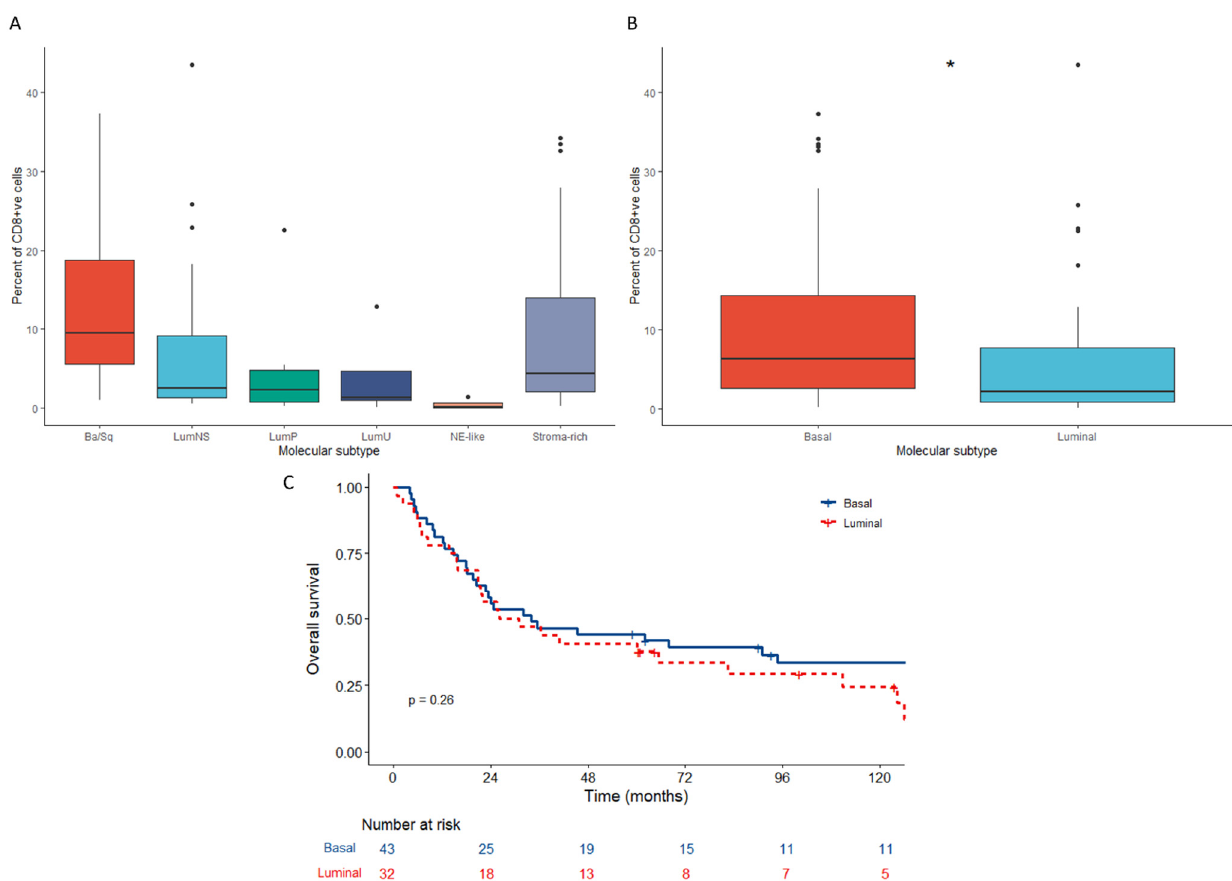
Figure 5. Boxplots showing the association between the percent of CD8 and the molecular subtype as assigned ( A ) using “consensusMIBC” package in R ( n = 80) and ( B ) further stratification into basal (basal/squamous and stroma-rich) and luminal (LumP, LumU, LumNS) subtypes with NE-like excluded ( n = 75). Statistical tests are Wilcox tests with p values < 0.05 are represented by *. ( C ) Kaplan–Meier plot for overall survival according to first order molecular subtypes (basal/luminal with NE-like excluded; n = 75). p values are log rank tests calculated using “survival” and “survminer” packages in R.